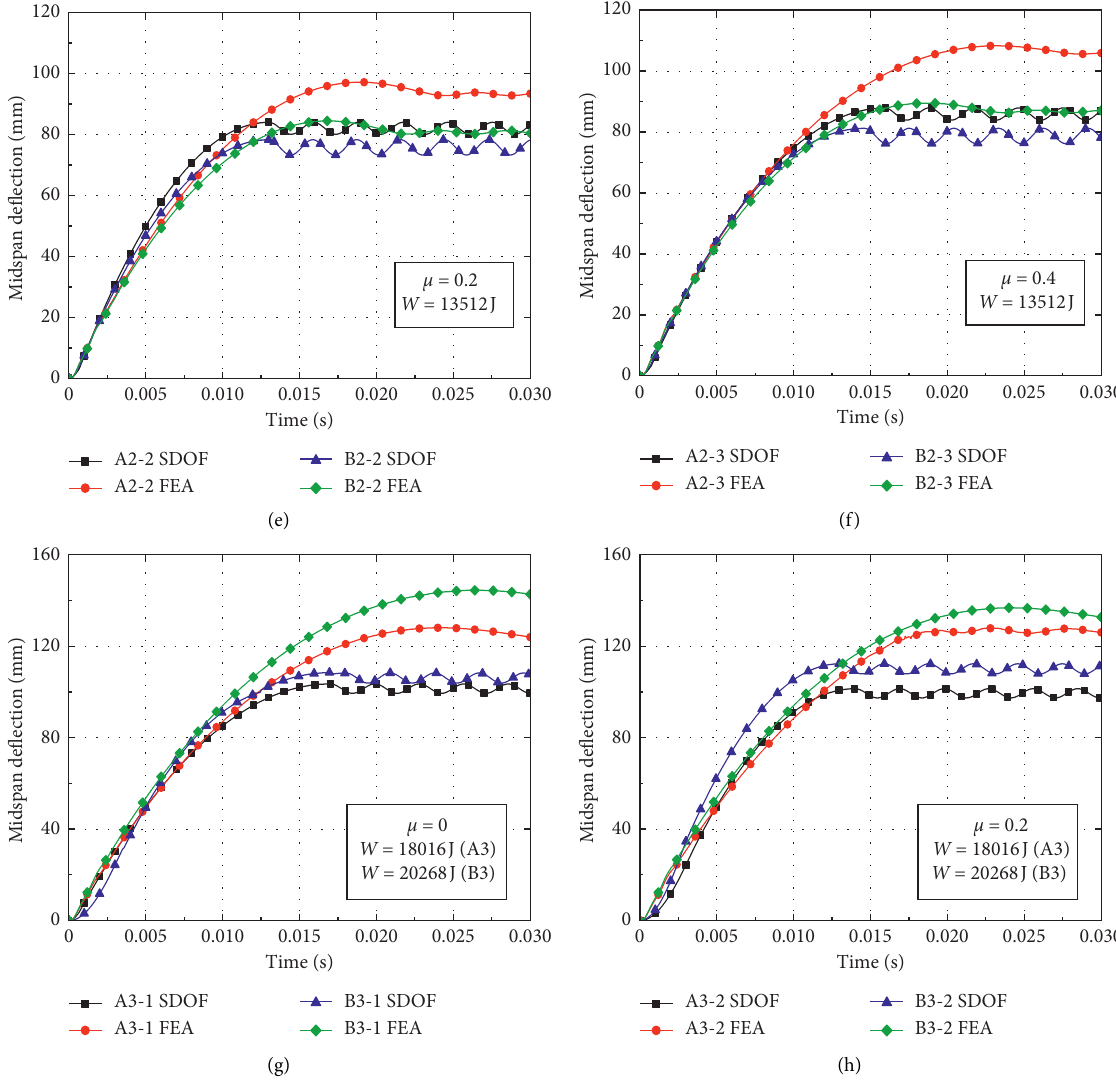
Figure 10: Deflection time histories obtained by the proposed calculation method and numerical simulation. (a) A1-1 and B1-1. (b) A1-2 and B1-2. (c) A1-3 and B1-3. (d) A2-1 and B2-1. (e) A2-2 and B2-2. (f) A2-3 and B2-3. (g) A3-1 and B3-1. (h) A3-2 and